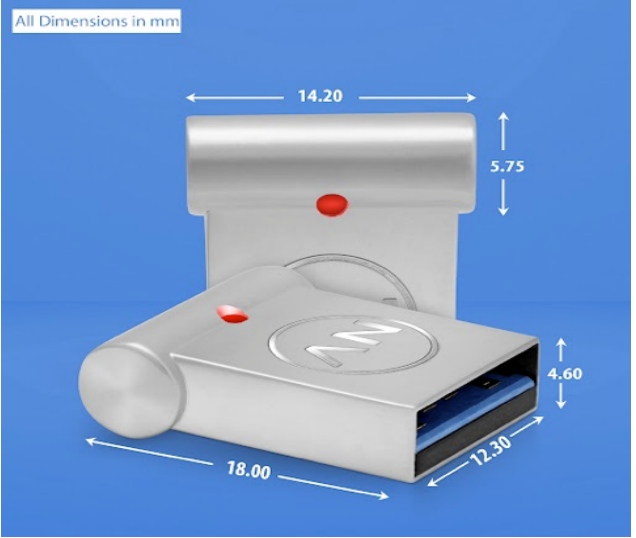
Figure 8. The design and dimensions (mm) of the ZVC powered hardware wallet device.